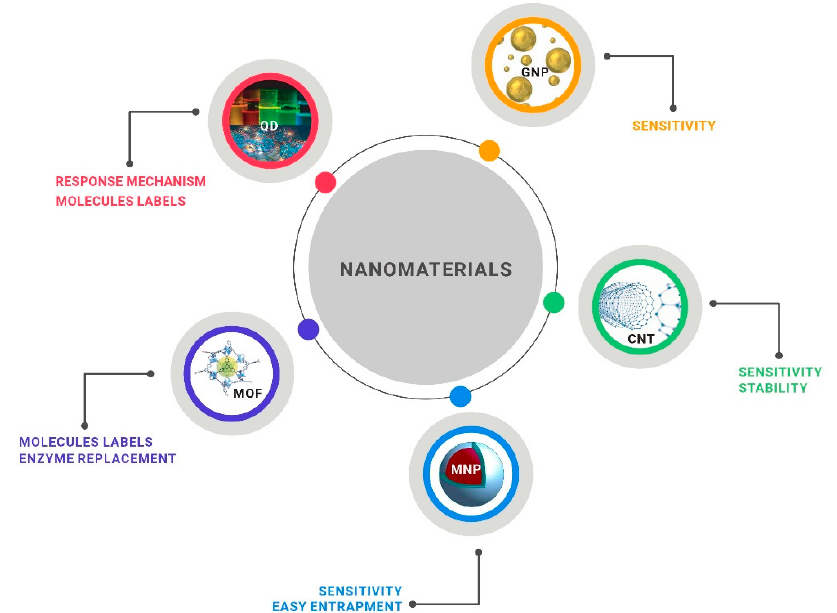
Figure 5. Types of nanomaterials commonly used in structured biosensors and their main contribu- tions to the devices’ performance.